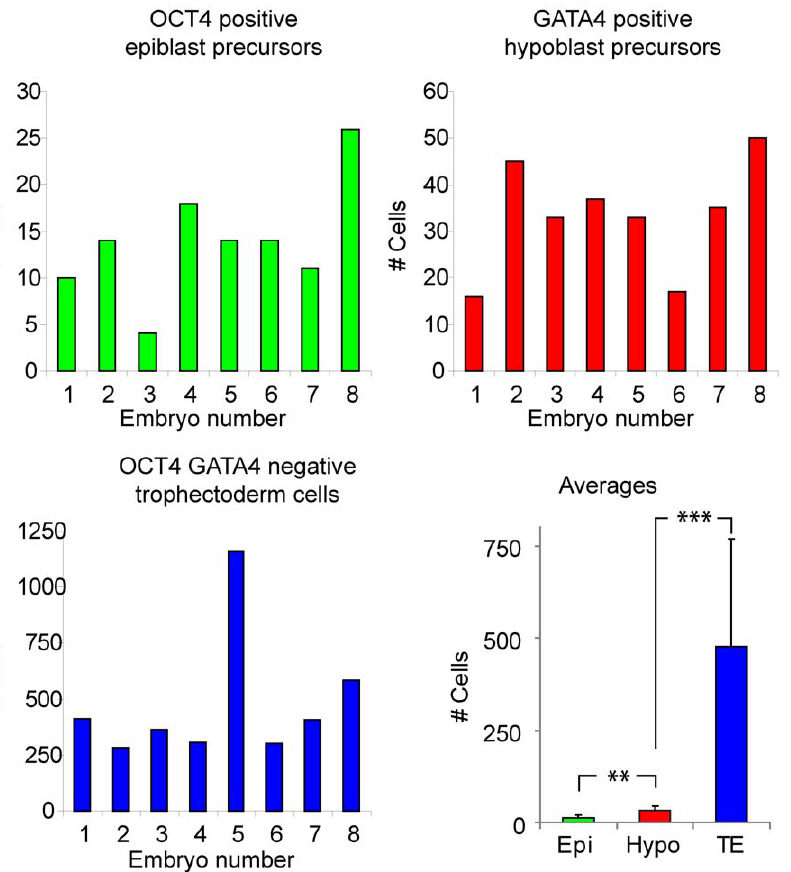
Figure 3. The number of cells per lineage in human embryos. The number of cells in each lineage in embryos that have been co-cultured with decidualized endometrial cells for 72 h. Green bars are the number of OCT4 positive epiblast precursors, red bars are the number of GATA4 positive hypoblast precursors, blue bars are the number of OCT4- and GATA4- negative trophectoderm cells. Error bars denote standard deviation; asterisks denote significant differences: **: p , 0.01; ***: p , 0.001. Epi=Epiblast lineage; Hypo=Hypoblast lineage; TE=Trophectoderm lineage.